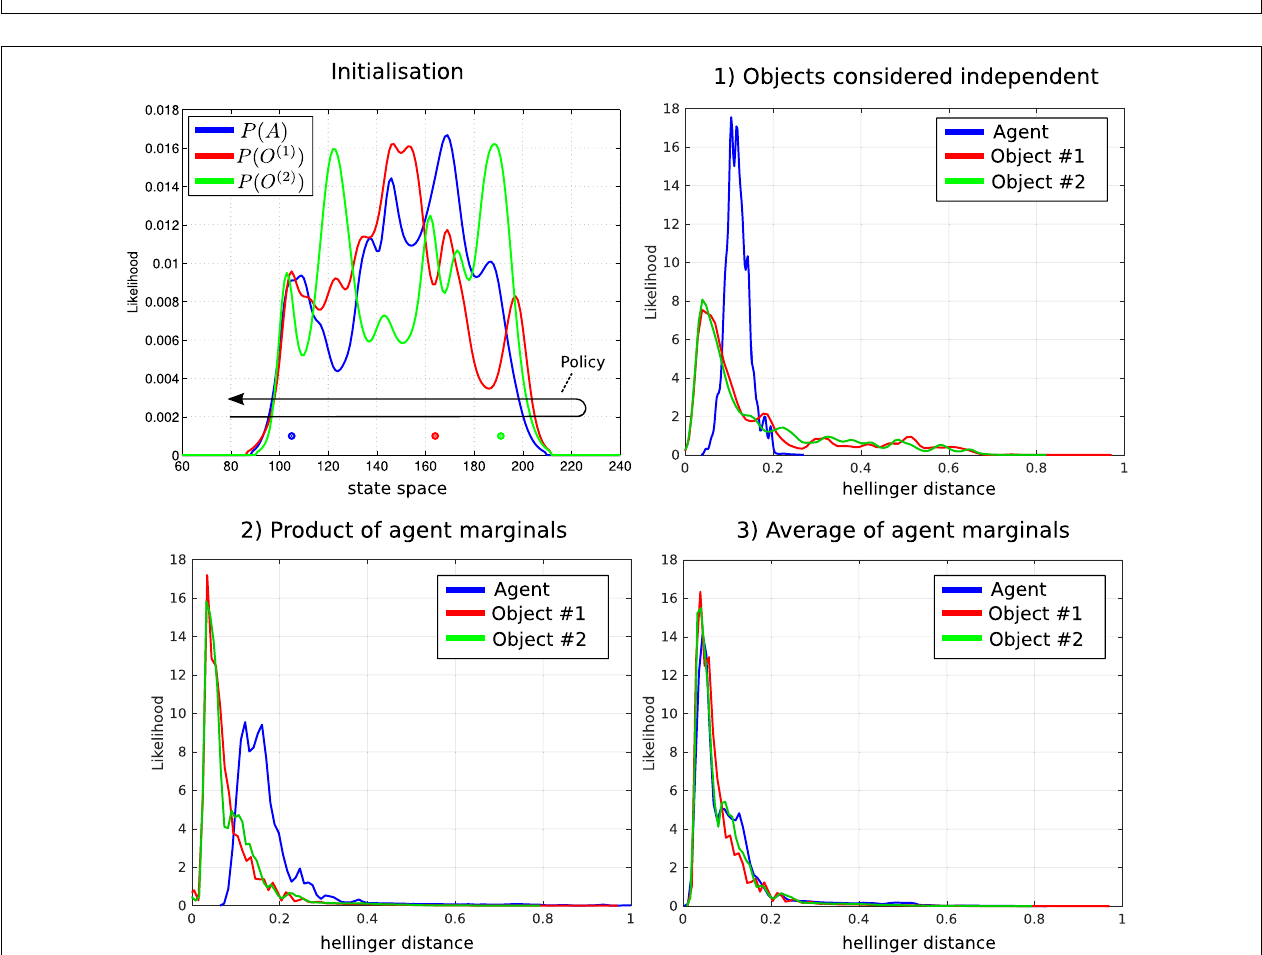
FIGURE 12 | Comparison of scalable-MLMF and the histogram filter. A deterministic sweep policy was carried out for 100 different initializations of the agent and object beliefs. Top left : one particular Initialization of the agent and object random variables. The true position of the agent and objects was sampled at random. The black arrow indicates the general policy, which was followed for each of the 100 sweeps. These were performed for (1) scalable-MLMF with objects considered to be independent at all times ( Algorithm A2 ). (2) Agent marginal P ( A t | Y 0: t , u 1: t ) is the product of marginals P ( A ( i ) t | Y ( i ) 0: t , u 1: t ) , equation (24). (3) Marginal P ( A t | Y 0: t , u 1: t ) is taken to be the average of all marginals P ( A ( i ) t | Y ( i ) 0: t , u 1: t ) , equation (25). For each of these three experiments, we report the kernel density estimation over the Hellinger distances taken at every time step between ground truth (from histogram filter) and scalable-MLMF.